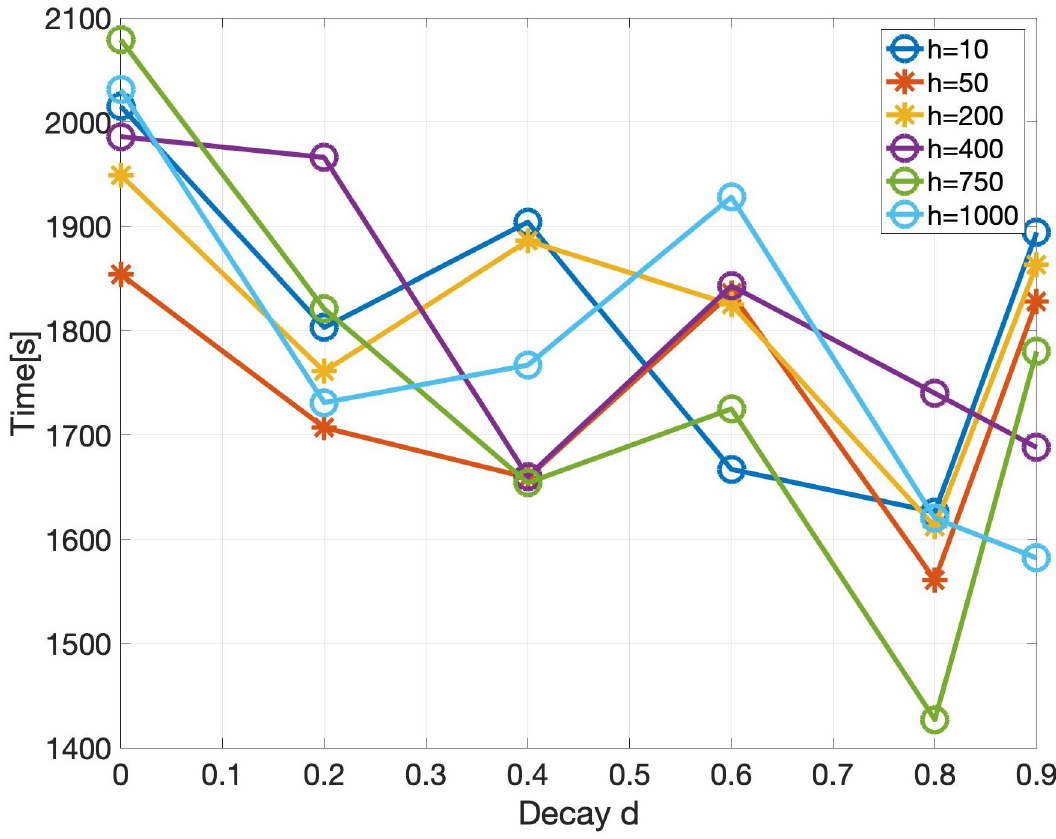
Fig 7. Plot of time for simulation vs the decay d for various values of horizon h . The decay and horizon are parameters that determine the event-triggered communication threshold.